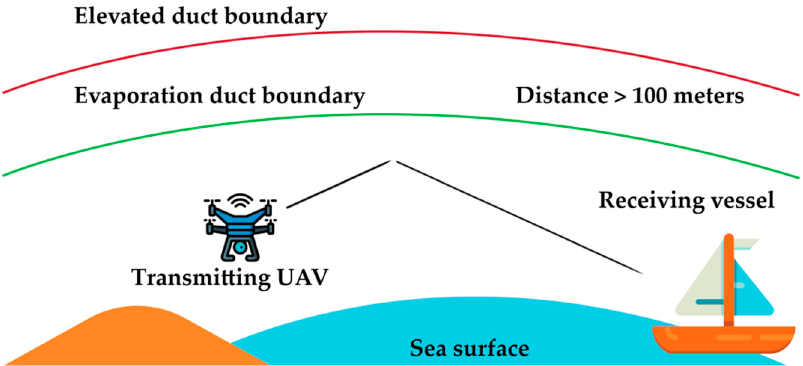
Figure 11. Scenario of marine communication between an unmanned aerial vehicle (UAV) and a mobile vessel at low altitude.